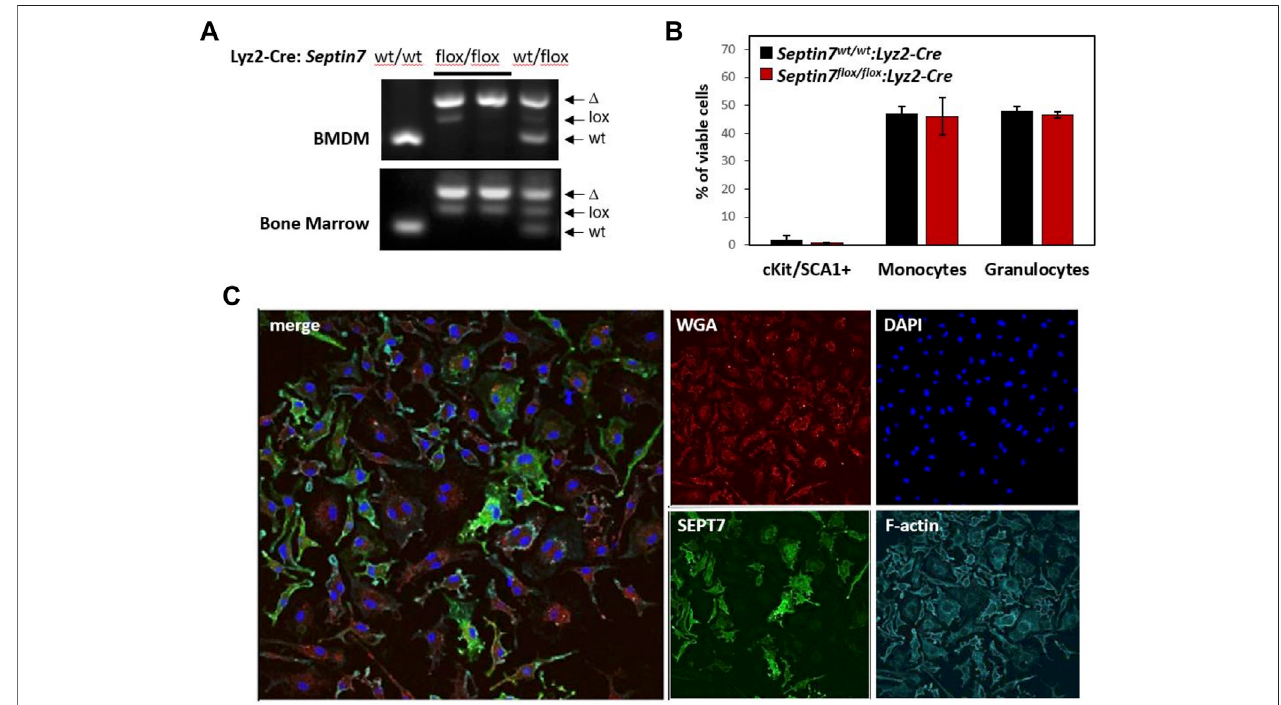
FIGURE 1 | Effect of myeloid Septin7-deletion in myelopoiesis and BMDM proliferation. (A) Septin7-genotye analyses of bone marrow (BM) cells and BM-derived macrophages (BMDM) from the myeloid speci fi c Septin7-KO mice show ef fi cient deletion of the fl oxed allele. (B) Cell surface marker analysis of BM cells from Septin7 fl ox/ fl ox :Lyz2-Cre and Septin7 wt/wt :Lyz2-Cre reveal no signi fi cant differences ( n (cid:1) 3 mice each, p value > 0.3) in stem/progenitors (cKit + and Sca1 + ), monocytes (CD11b + andF4/80 + ) and granulocyte (Gr1 + andCD11b + ) populations. (C) Immuno fl uorescence analysisshowing obligatory binucleationof Septin7 -KOBMDMs. DAPI is used for nuclear staining, WGA and Phalloidin (staining F-actin) are shown as counter stains. Septin7-negative cells display more than one nucleus, whereas Septin7-positive cells (stained green) display only